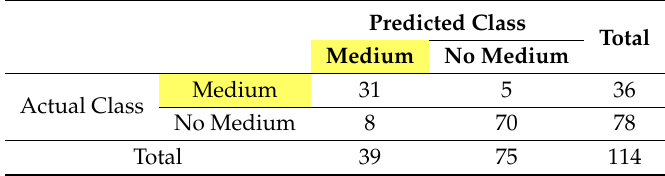
Table 7. Binary contingency table for the class (of exposure)